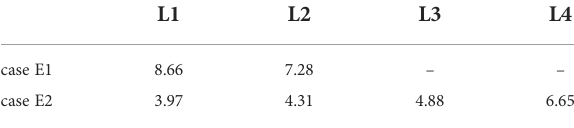
TABLE 2 Root mean squared percentage error (RMSPE) on DVH between laboratory experiments and numerical simulations. L1 L2 L3